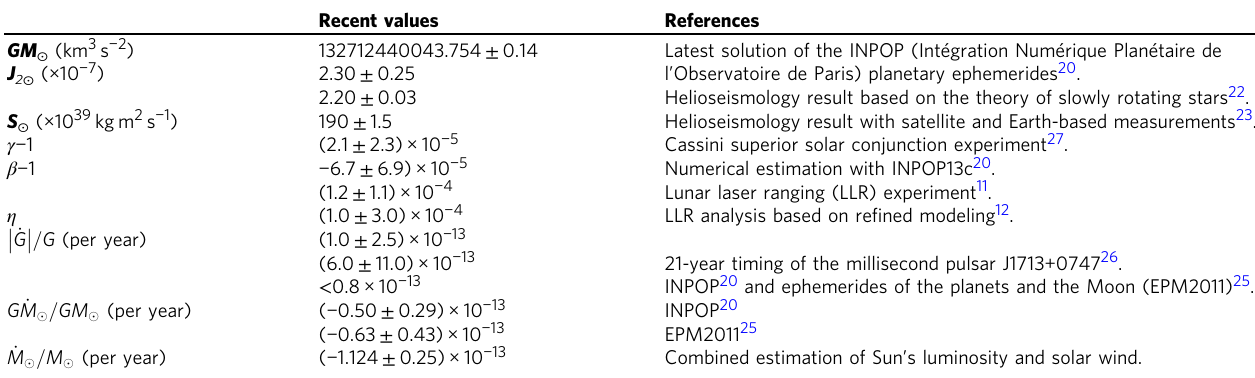
Table 1 Current knowledge of general relativity and heliophysics parameters Recent